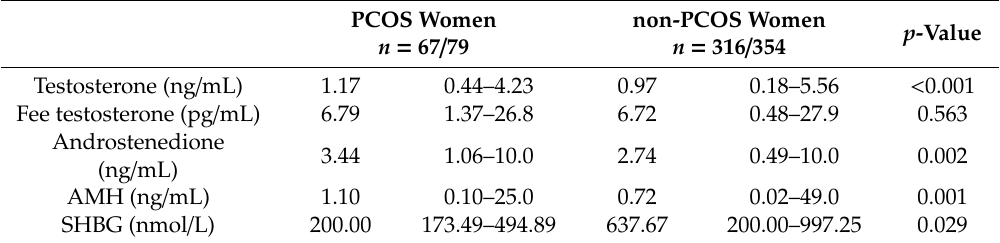
Table 2. Comparison of androgens and anti-Mullerian hormone (AMH) in PCOS women and non-PCOS women. SHBG: sexual hormone-binding globulin.